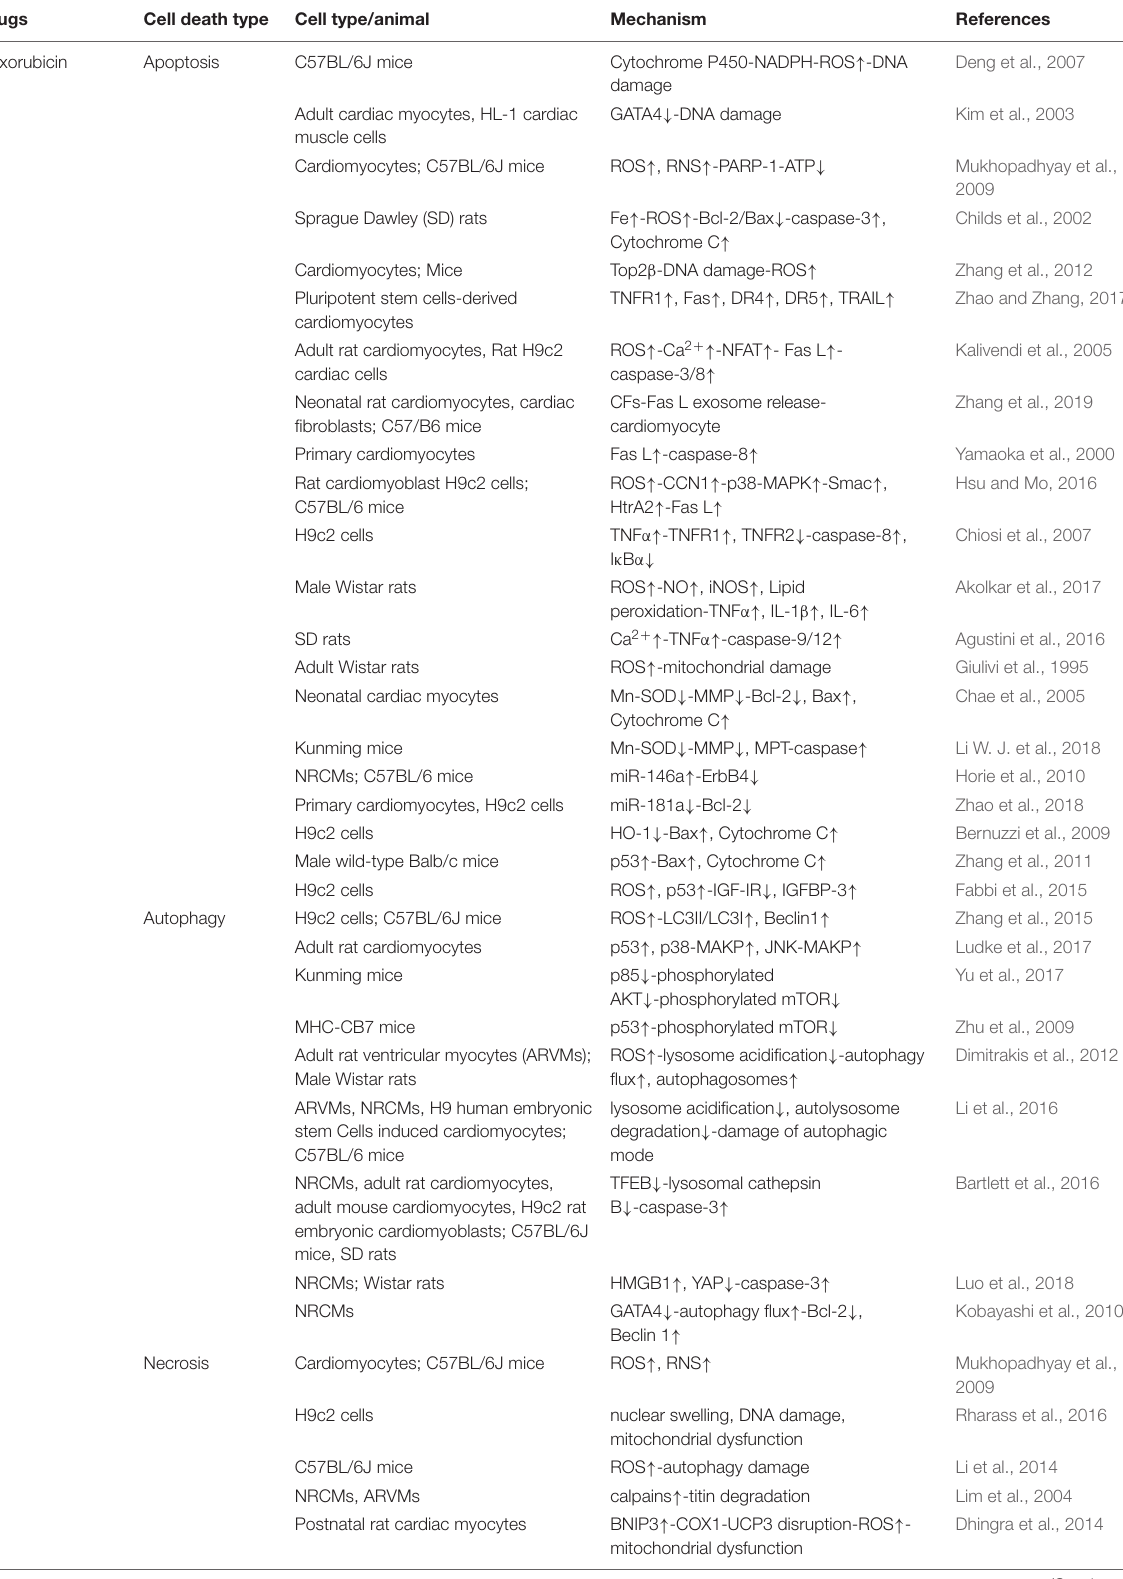
TABLE 1 | Molecular mechanisms of cardiomyocyte death in drug-induced